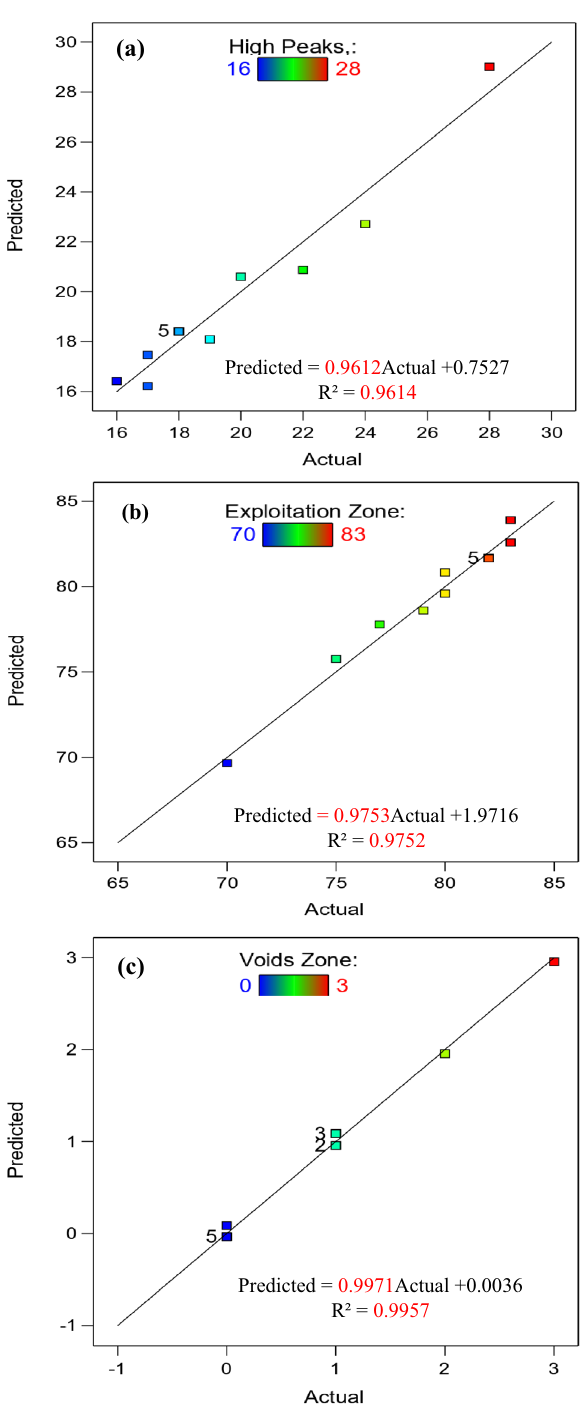
Figure 16. Relationship between actual and predicted Abbott Firestone zones of